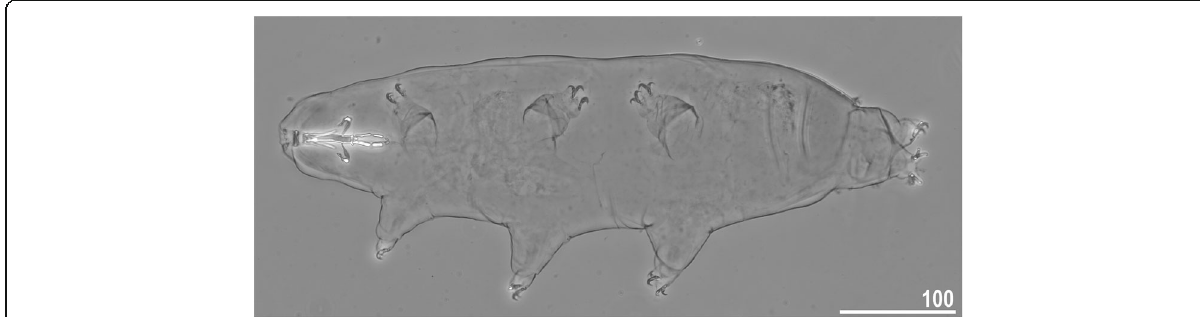
Fig. 12 Macrobiotus pseudopallarii sp. nov. from Montenegro (ME.007) – habitus, adult specimen in dorso-ventral projection (holotype). Scale bar